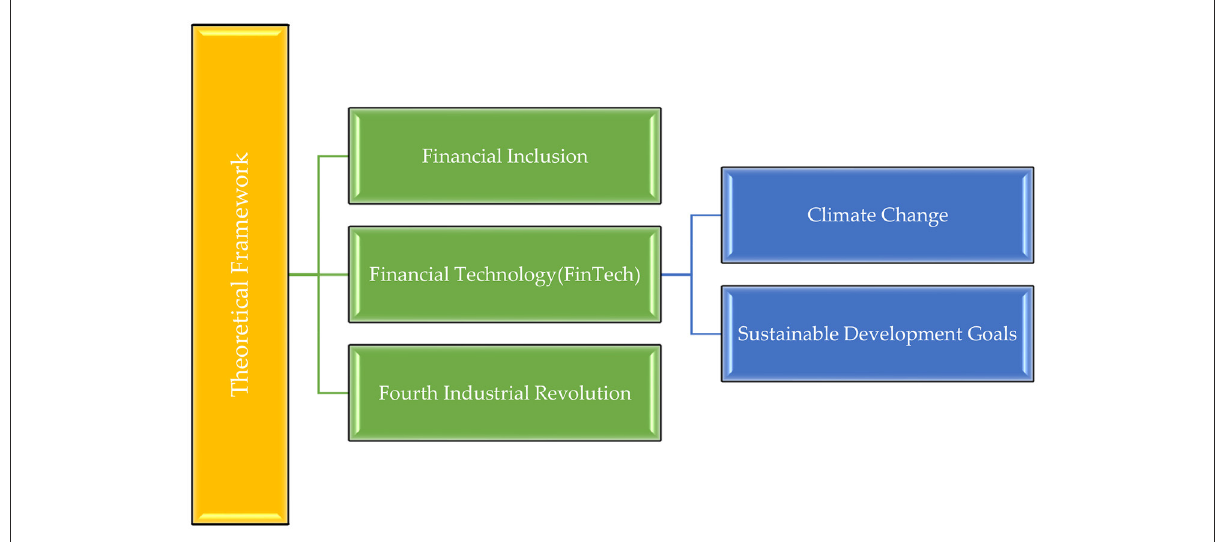
FIGURE1 The theoretical framework. Source: The author’s